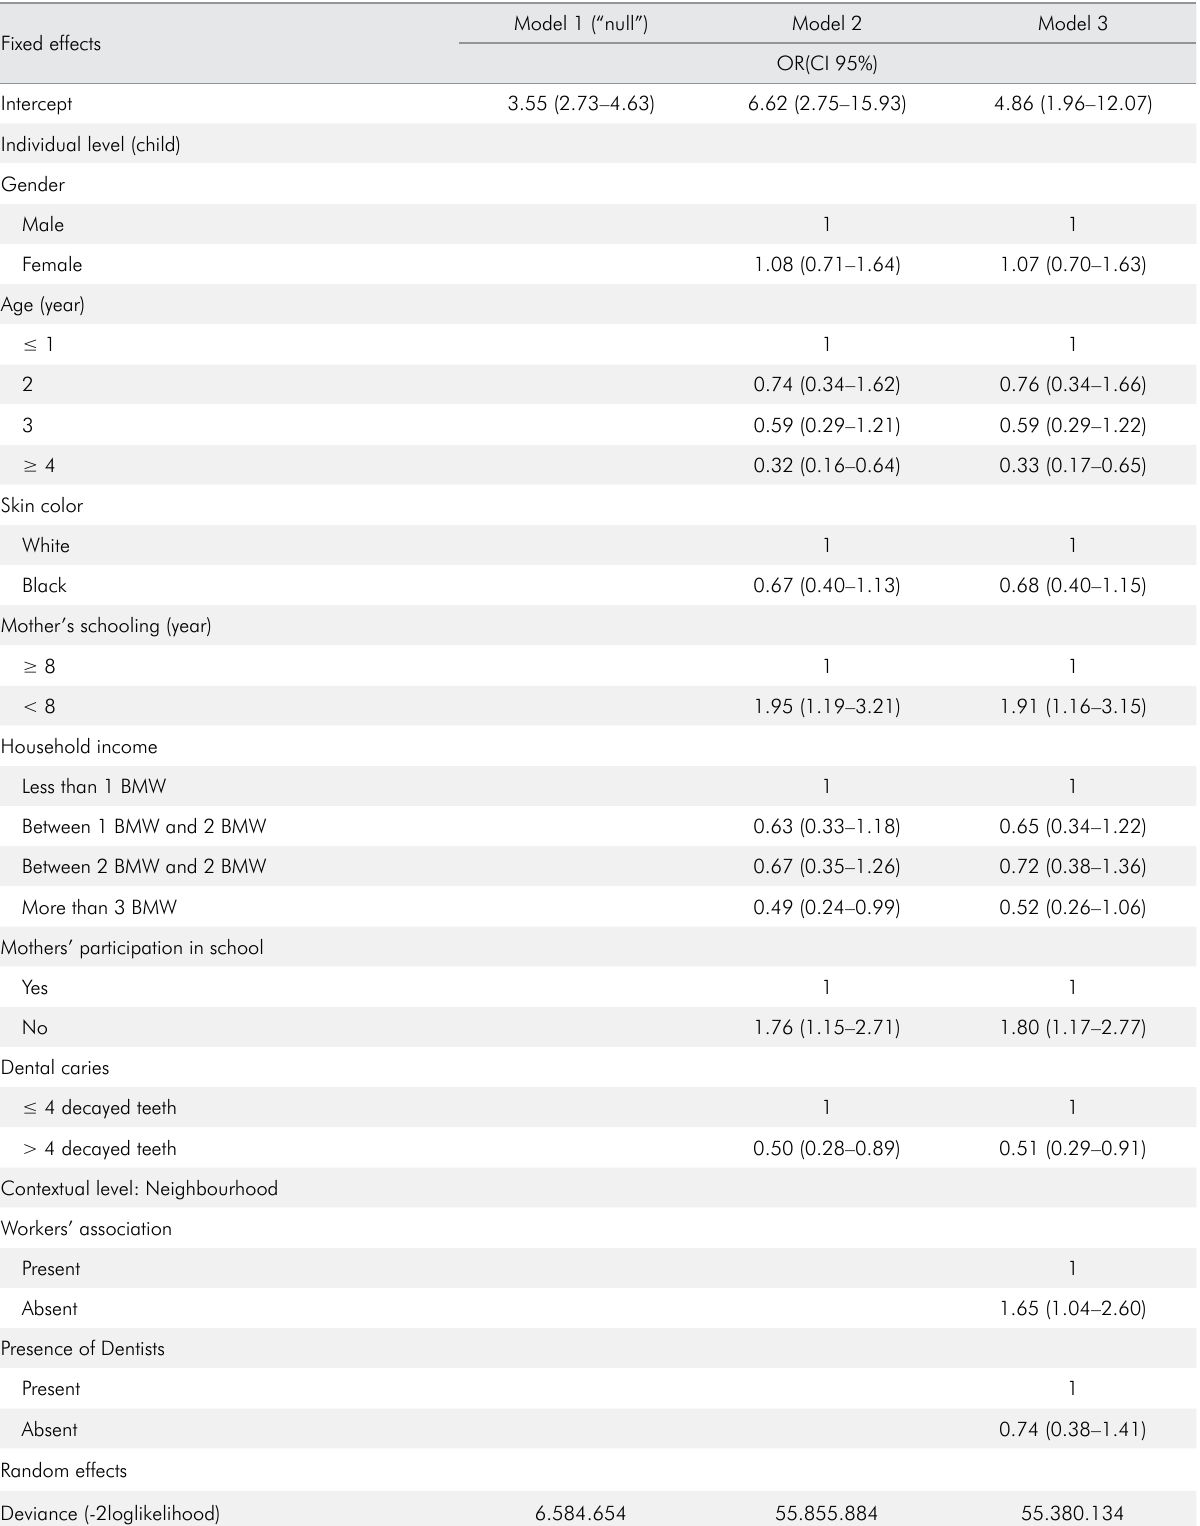
Table 3. Multilevel Adjusted Assessment of dental health care use among preschool children associating individual and contextual